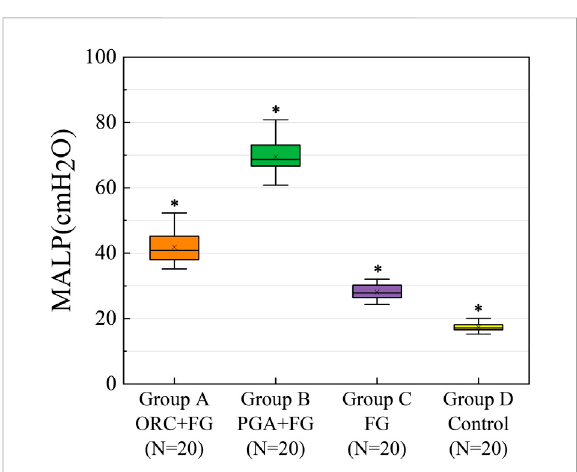
FIGURE 6 The MALP of the intersegmental plane in each experimental group.MALPwassigni fi cantlyhigherinthegroupA,ascompared with the group C and group D (both p < 0.001) with a signi fi cant difference between the latter two groups ( p < 0.001). A signi fi cantly greater MALP was obtained for group B than the other groups (both p < 0.001). The upper and lower borders of the box represent, the upper and lower quartiles. The middle horizontal line represents the median. The cross represents the mean. The whiskers show the minimum and maximum values excluding the outliers. * p < 0.05, group A versus group B versus group C versus group D. MALP (minimum air leakage pressure), ORC (oxidized regenerated cellulose), PGA (polyglycolic acid), FG ( fi brin